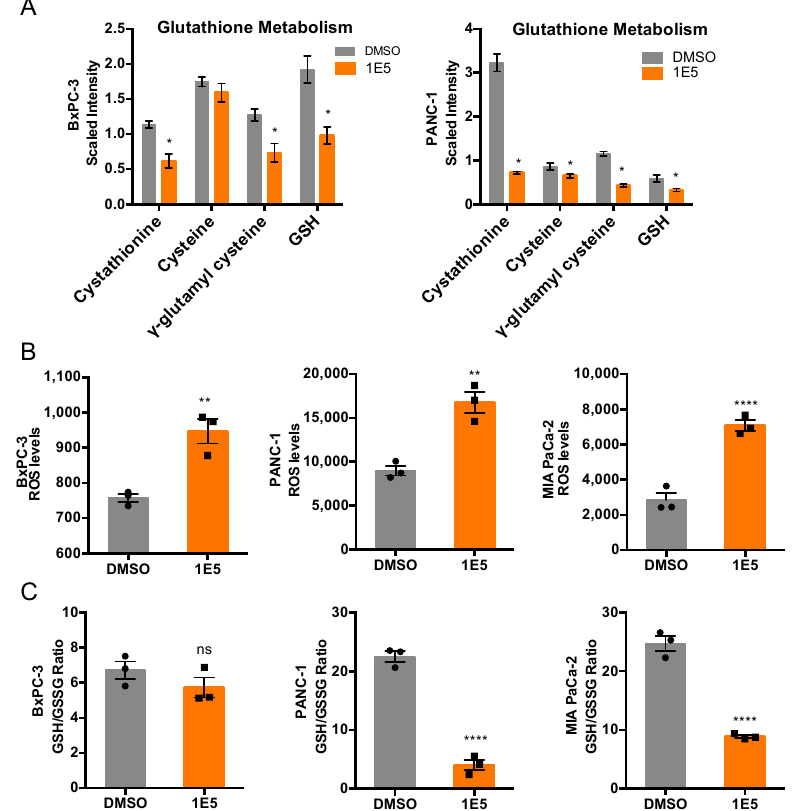
Figure 5. 1E5 treatment induces oxidative stress response in BxPC-3 and PANC-1 cells. ( A ) Overview of the transsulfuration pathway and glutathione biosynthesis in cells. ( B , C ) Glutathione metabolism metabolite levels quantified by mass spectrometry in BxPC-3 ( n = 5) and PANC-1 ( n = 6) cells following 48 h treatment with DMSO and 1E5. Statistical significance determined by t -test, where * p < 0.05. ( B ) H 2 O 2 luminescence normalized by cell number following 48 h treatment with DMSO and 1E5 in BxPC-3, PANC-1, and MIA PaCa-2 cells. ( C ) Ratio of reduced to oxidized glutathione (GSH/GSSG) following treatment with DMSO and 1E5 in HBSS bu ff er for 48 h. Data representative of mean ± SEM, n = 3 independent biological replicates. Statistical significance determined by one-way ANOVA, where * p < 0.01, ** p < 0.001, **** p < 0.0001, ns p >